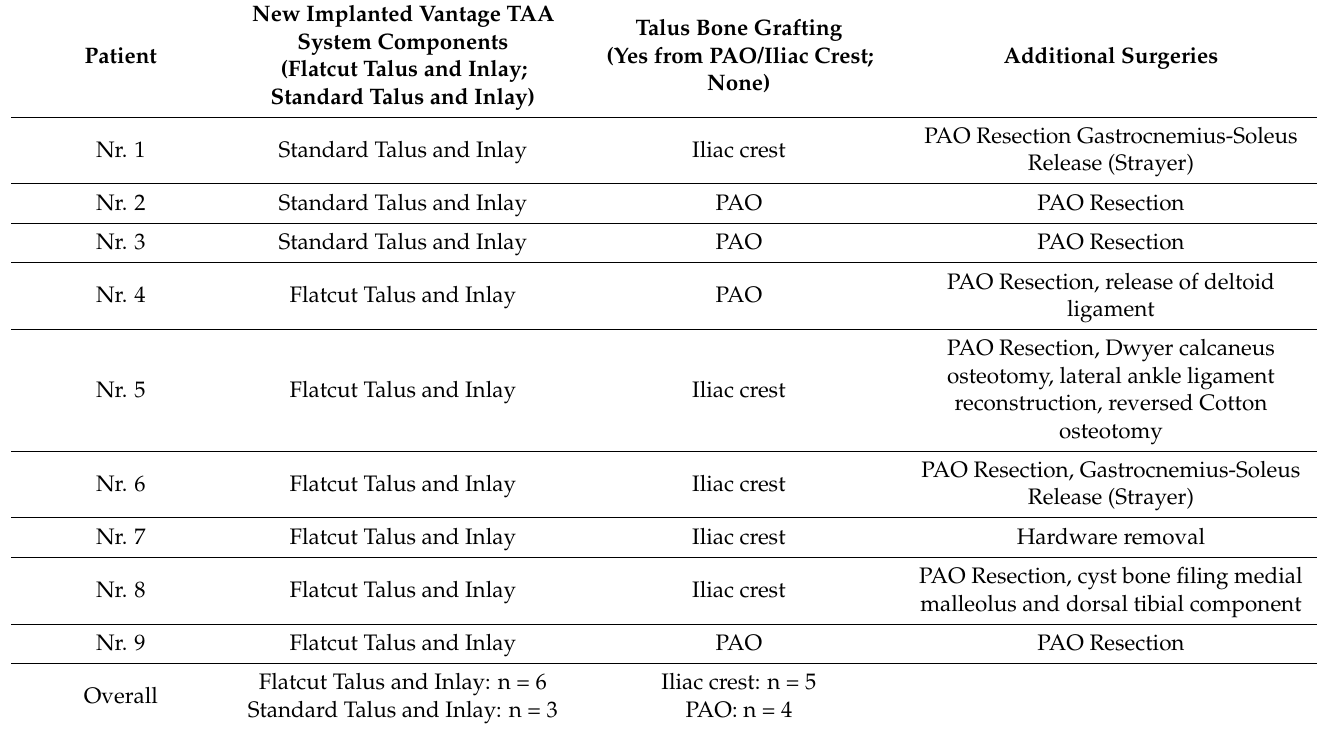
Table 2. Revision Total Ankle Arthroplasty (TAA) Surgery with Hybrid-TAA